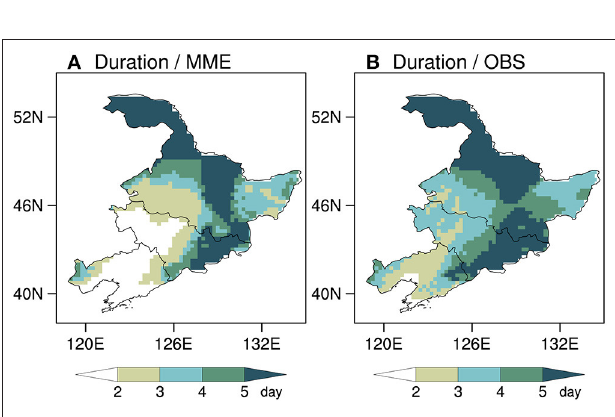
FIGURE 3 | Spatial patterns of chilling damage duration (unit: day) for (A) LMDZ-MME and (B) observation in Northeast China during